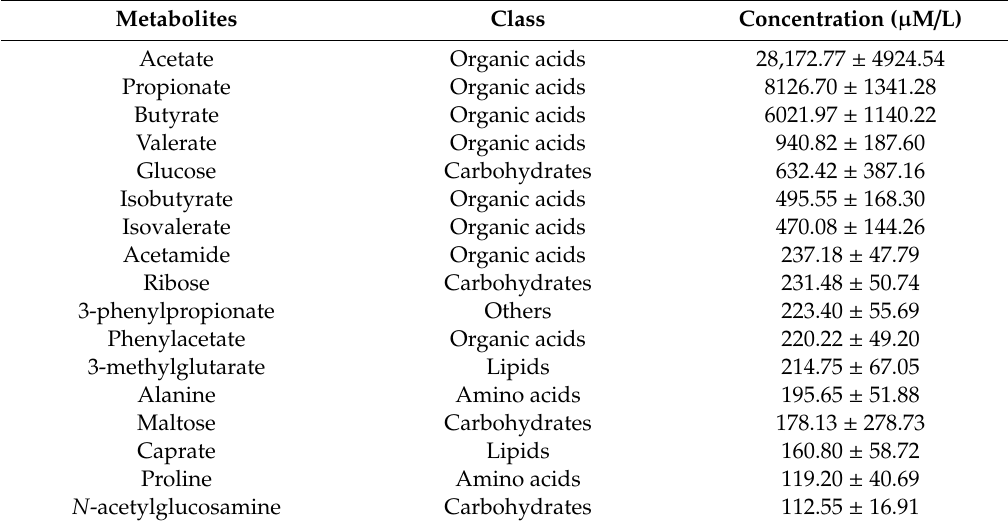
Table 1. Top 30 concentration (mean ± standard deviation) of metabolites quantified ( n ≥ 4) in rumen fluid by 1 H-NMR spectroscopy of Hanwoo steers.